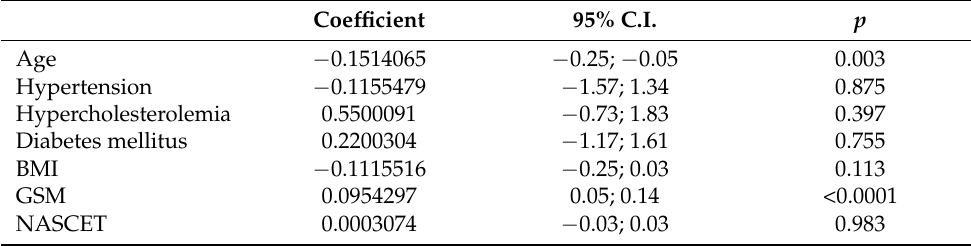
Figure 1. Spearman’s correlation between gray-scale median (GSM) and z-score at baseline (rho = 0.464; p < 0.0001). Table 2. Linear regression analysis for prediction of z-score at baseline.